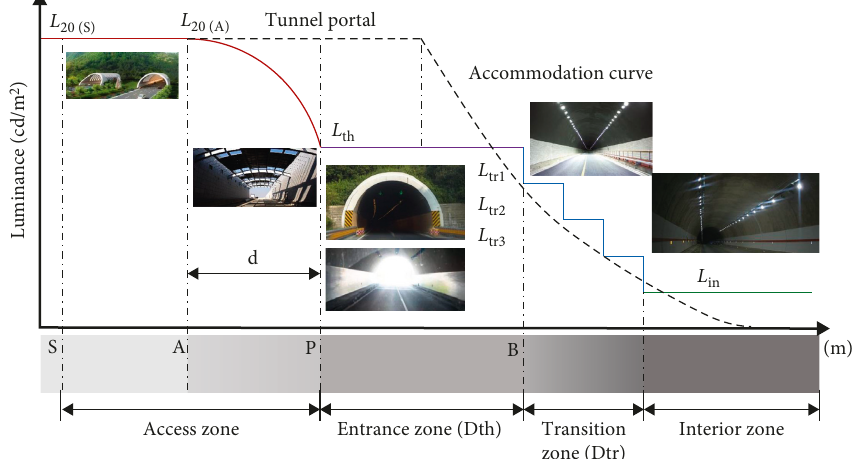
Figure 9: Illumination system of a highway